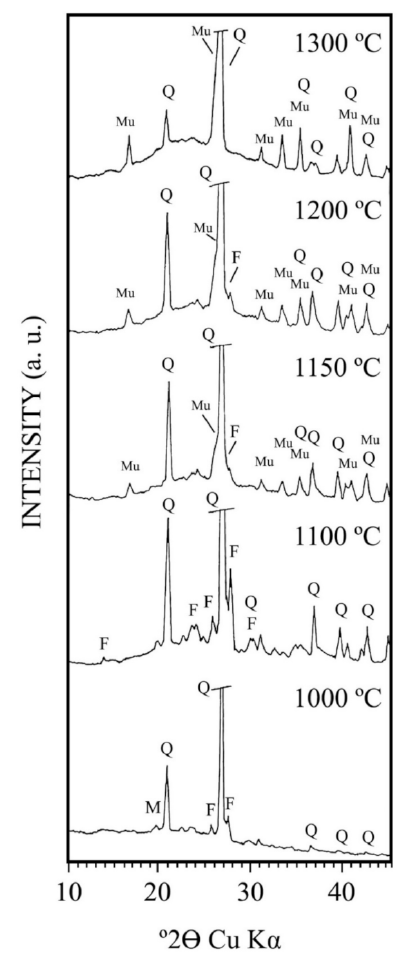
Figure 10. XRD diagrams of the kaolin sample (fraction under 63 µ m) fired up to 1300 ◦ C. M = mus- covite (dehydroxylated); Q = quartz; F = feldspar (microcline); Mu = mullite.